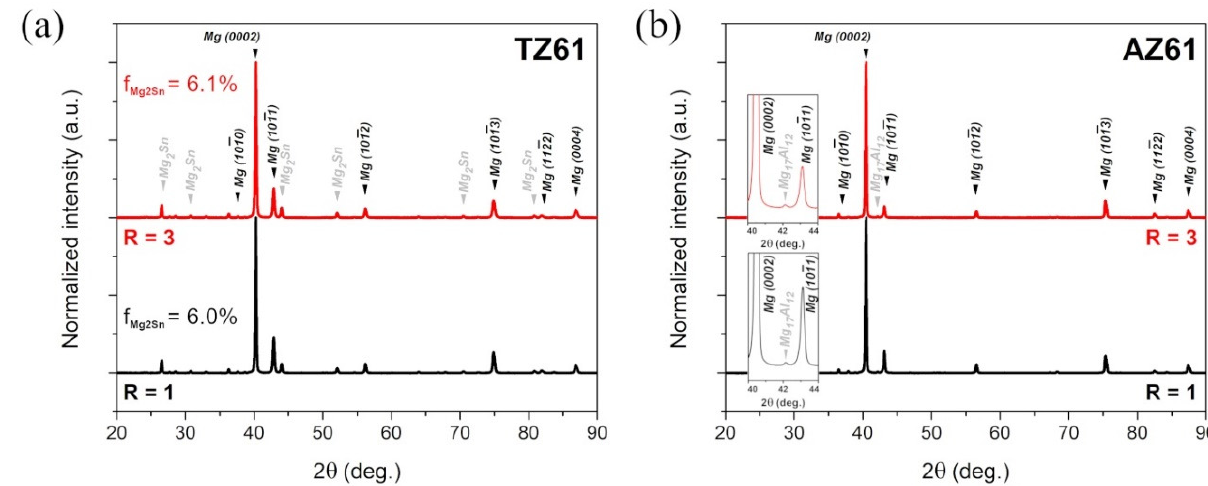
Figure 3. XRD patterns of as-rolled ( a ) TZ61 and ( b ) AZ61 sheets processed at speed ratio of R = 1 and 3.